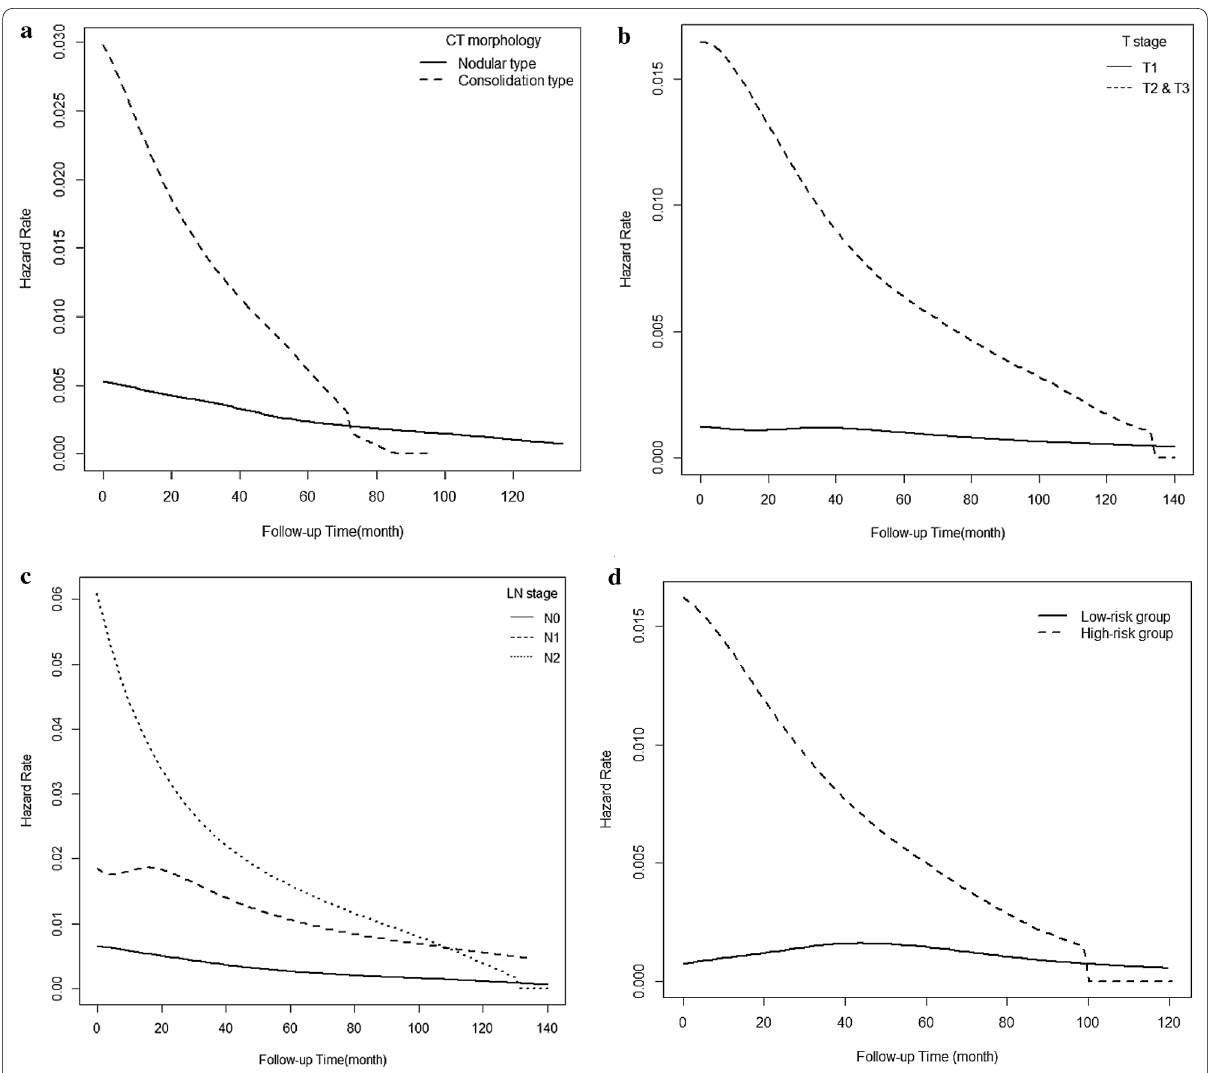
Fig. 2 Comparison of recurrence hazard rate according to CT morphology ( a ), T stage ( b ), N stage ( c ), and recurrence hazard rate comparing groups with at least one of the significantly unfavorable factors (consolidative morphology, higher T and N stage [high risk group]) and those without (low risk group) ( d ) in patients with invasive mucinous